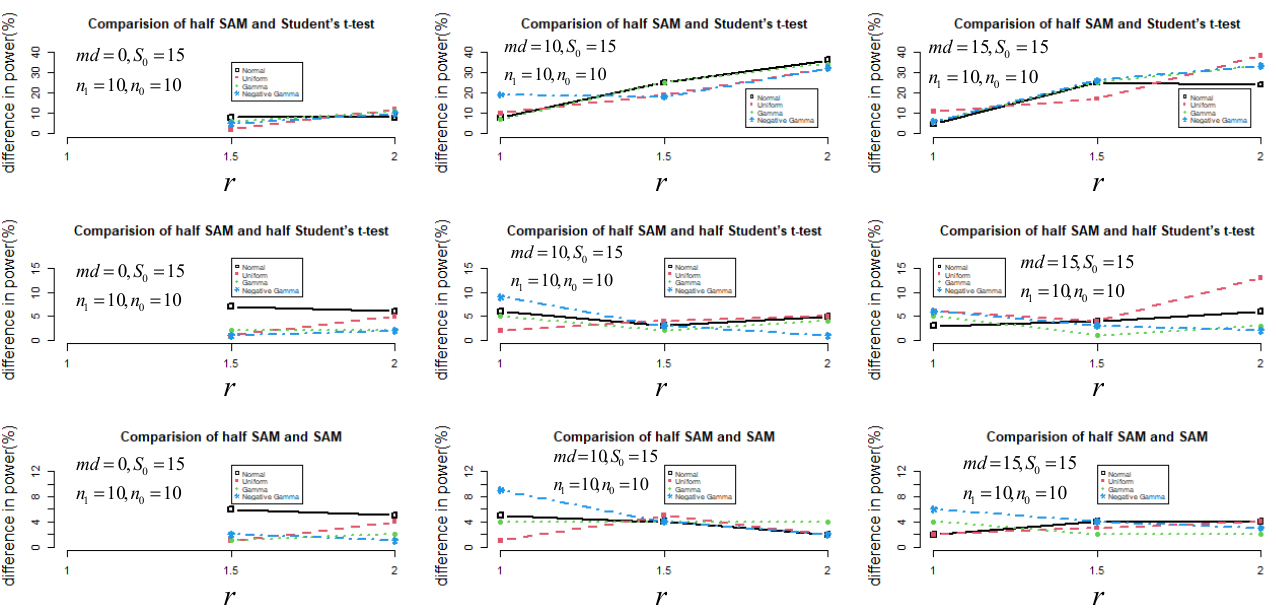
Figure 2. The difference in power (%) between half SAM and SAM (or half Student’s t -test and Student’s t -test) under small sample sizes for n 0 = n 1 = 10 with s 0 set to 15.